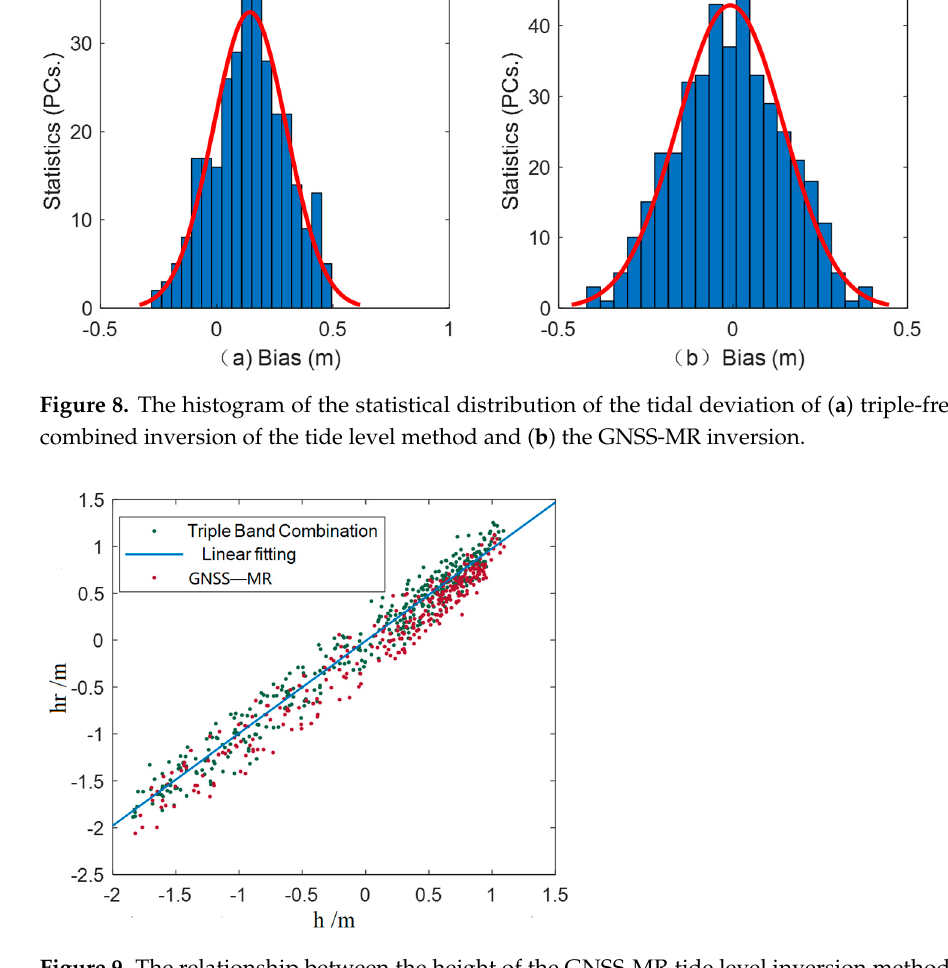
Figure 8. The histogram of the statistical distribution of the tidal deviation of ( a ) triple-frequency combined inversion of the tide level method and ( b ) the GNSS-MR inversion.